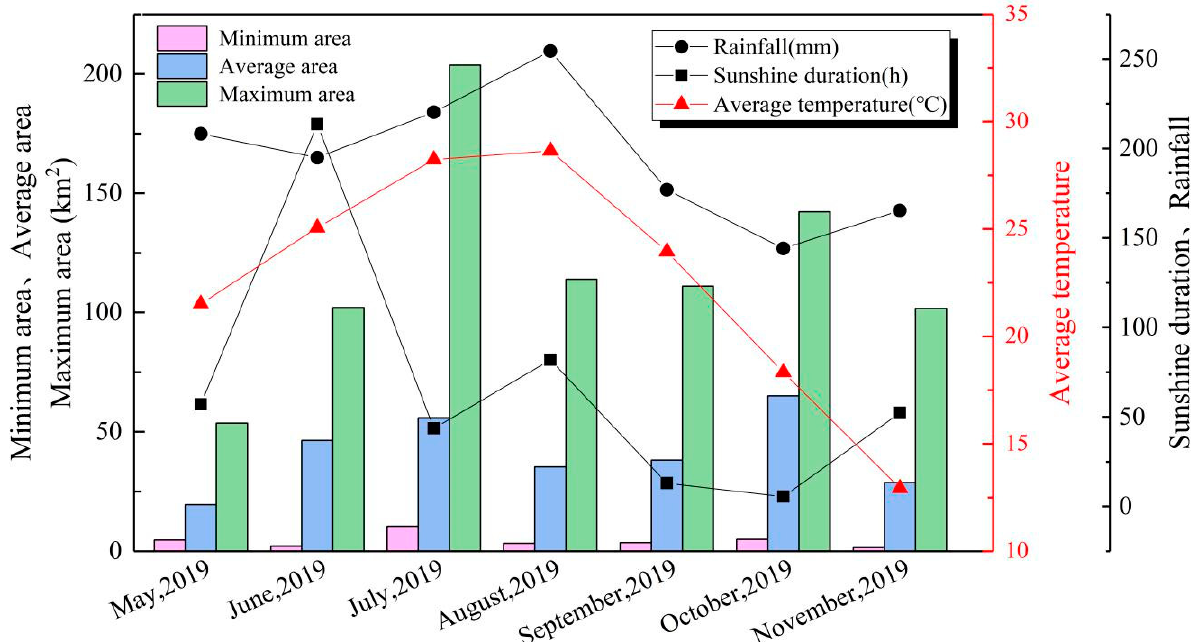
Figure 13. Chart of the minimum area, average monthly area, maximum area, average monthly temperature, sunshine hours, and precipitation of Chaohu Lake HABs.